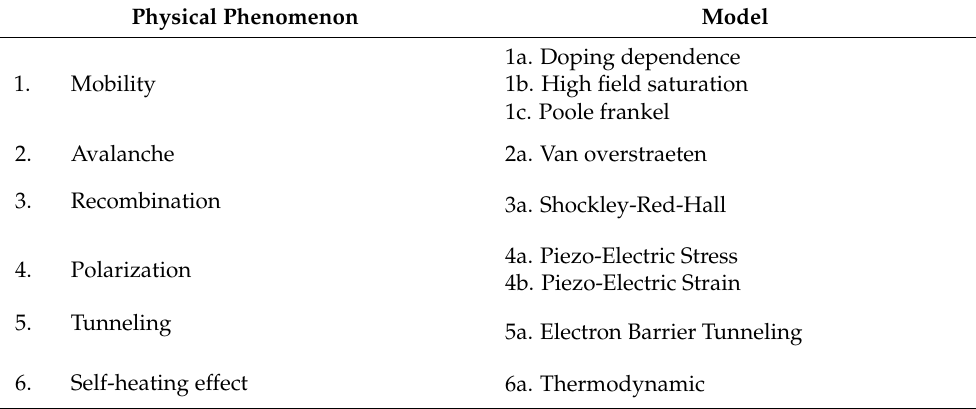
Table 1. Models used in GaN device simulation.